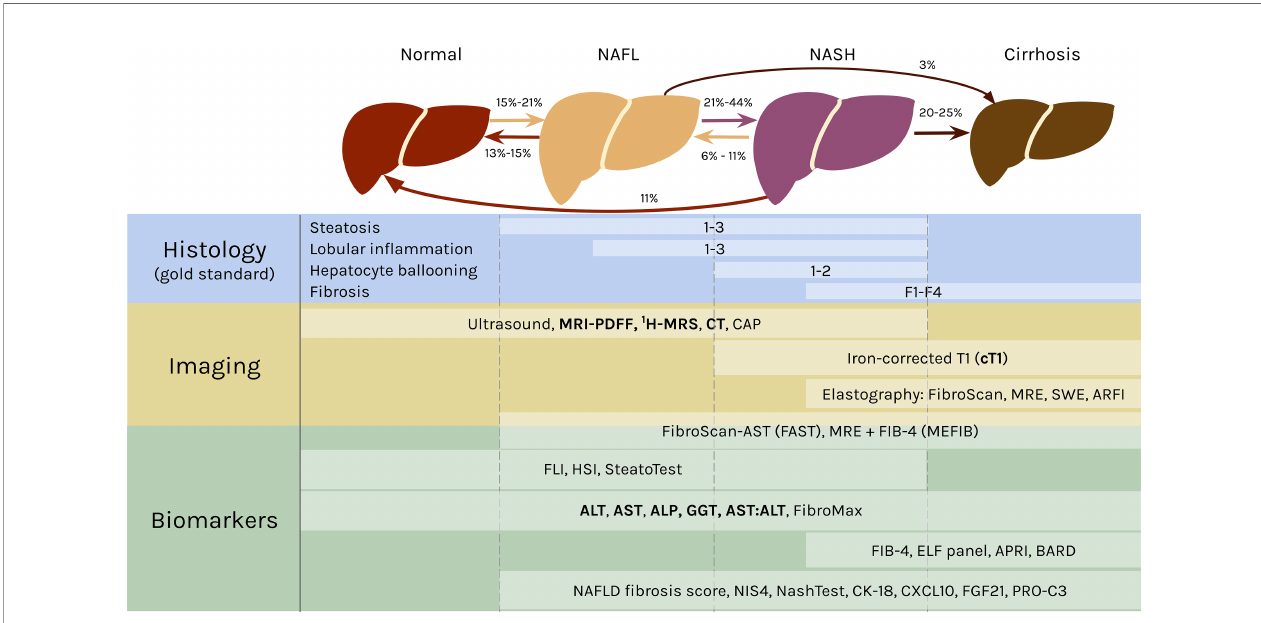
FIGURE 1 | The spectrum of NAFLD and stage speci fi c clinical measures. In NAFL, at least 5% of the hepatocytes have fat accumulation in the form of large lipid droplets in the cells that displace the nuclei (21) or many small lipid droplets (22). NAFL can also include in fl ammation. The transition to NASH occurs with hepatocellular injury in the form of ballooning and further in fl ammation. Fibrosis can develop in NASH and advance into cirrhosis, in which the liver shrinks and hardens. NAFL and NASH are reversible, as indicated by the rates regressing in severity. Both can also progress into cirrhosis. The rates of transition between each stage are broad ranges because they originate from studies with varying cohort sizes, time frames, treatments, and other variables (18, 19, 23 – 26). Histology is the gold standard for diagnosing NAFLD and classifying the stage of disease. The components of NAS are listed above, with the area to the left of the white bars indicating scores of 0 for each feature. A selection of noninvasive diagnostic methods are shown below, with white boxes representing their range in effectively diagnosing different stages of NAFLD [ultrasound (27); FAST (28); MEFIB (29); SteatoTest (30); FibroMax (31); BARD (32); NAFLD fi brosis score (33); NIS4 (34); NASHTest (35)]. The lists are not comprehensive, and the modalities mentioned in the mini-review are emphasized in bold. CAP, controlled attenuation parameter; obtained from FibroScan (36, 37). MRE, magnetic resonance elastography (38). SWE, shear-wave elastography (38). ARFI, acoustic radiation force impulse (37). FIB-4, fi brosis-4 (39). FLI, fatty liver index (40). HSI, hepatic steatosis index (41). ELF, Enhanced Liver Fibrosis (42). APRI, AST-to-platelet ratio index (43). CK-18, cytokeratin 18 (44). CXCL10, C-X-C motif chemokine ligand 10 (45). FGF21, fi broblast growth factor 21 (44). PRO-C3, plasma collagen type III